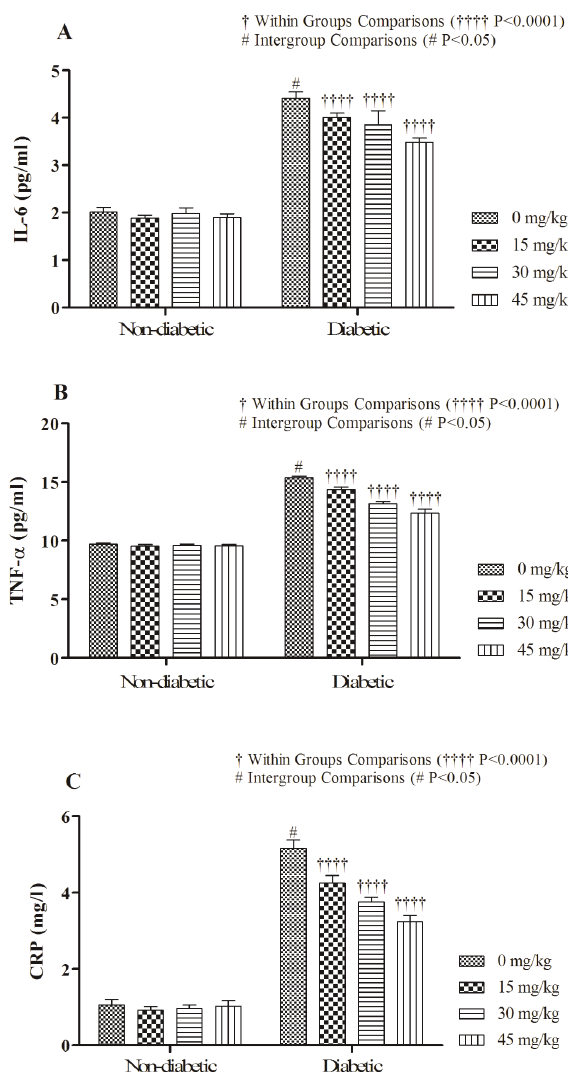
Figure 2. Effects of different levels of SN extract on inflammatory variables in diabetic and non-diabetic rats